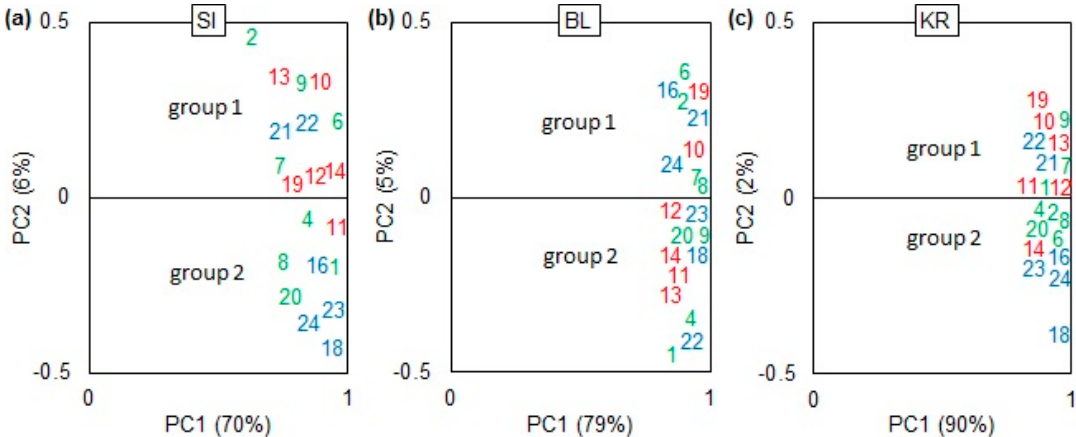
Figure 4. Grouping of the indexed chronologies of the larch provenances (see Figure 2b) from the provenance trials at Siemianice—SI ( a) , Bli˙zyn—BL ( b ) and Krynica—KR ( c ) in relation to the loadings of PC1 and PC2. The parentheses provide the percentages of the total variances of the chronologies explained by the individual principal components. The provenances that originated from Polish lowlands are marked in green, uplands in red and mountains in